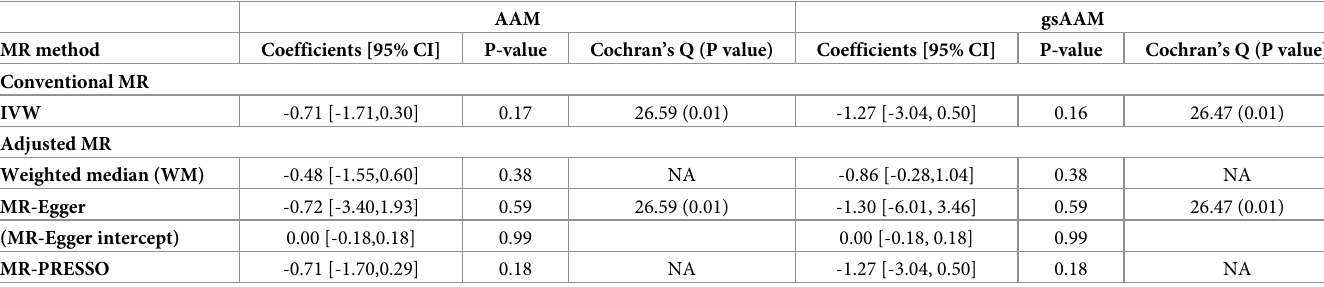
Table 4. Result of adjusted MR method for exploring the association between age at menarche (AAM) and young adulthood body mass index. AAM gsAAM MR